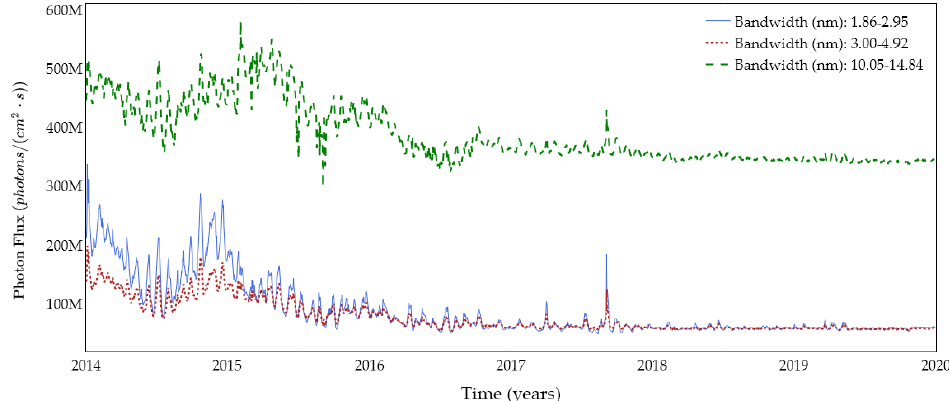
Figure 2. Variation in photon flux data for 3 different